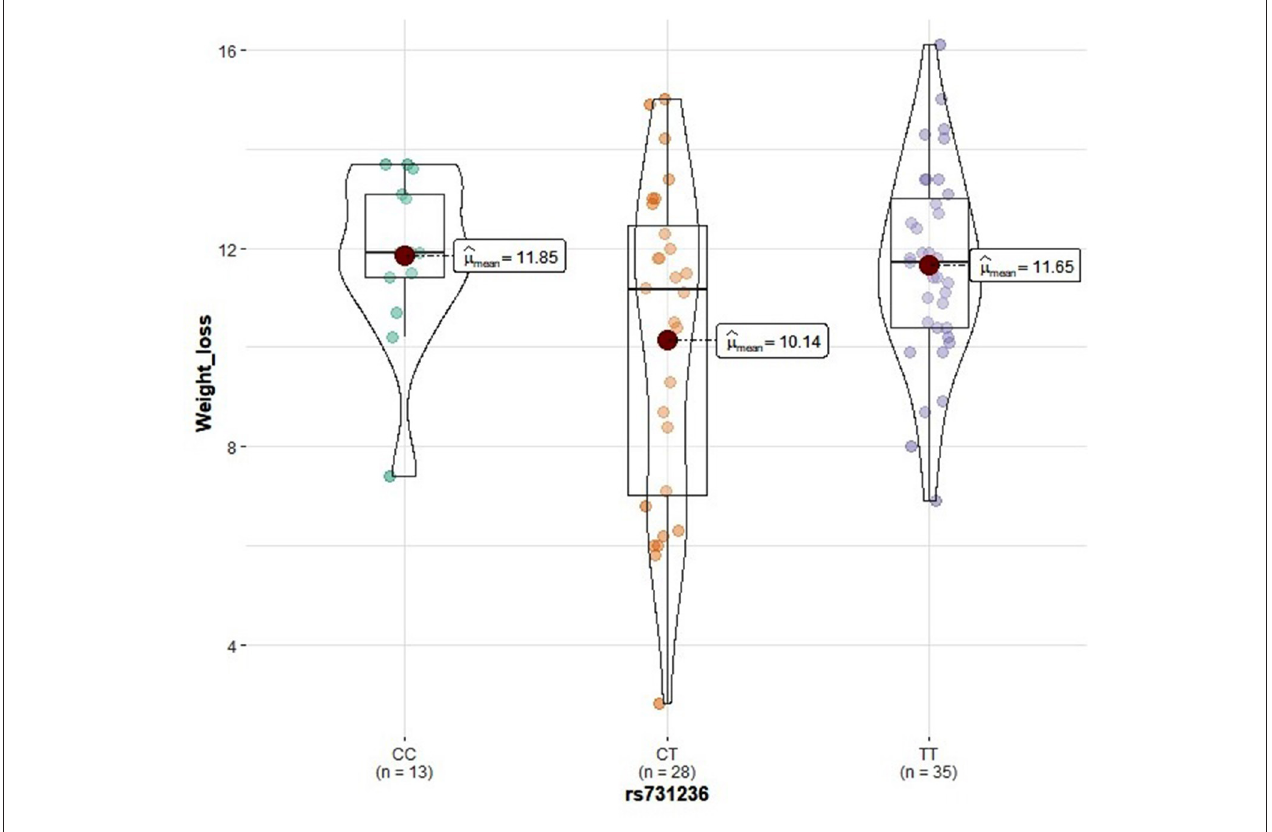
FIGURE 3 | Violin plots displaying the mean values of weight loss in the vitamin D group according to rs731236 genotype profile.